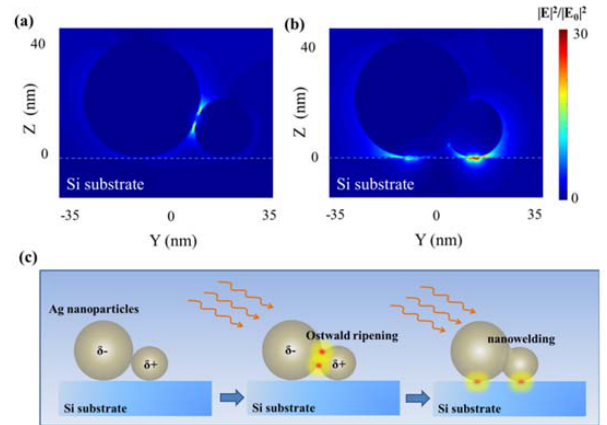
Figure 5. Plasmonic welding of Ag nanoparticles; ( a ) light enhancement of Ag nanoparticles (diameters 40 nm and 20 nm) in contact; ( b ) light enhancement of merged Ag nanoparticles; ( c ) schematic diagram of the plasmonic nanowelding of Ag nanoparticles.